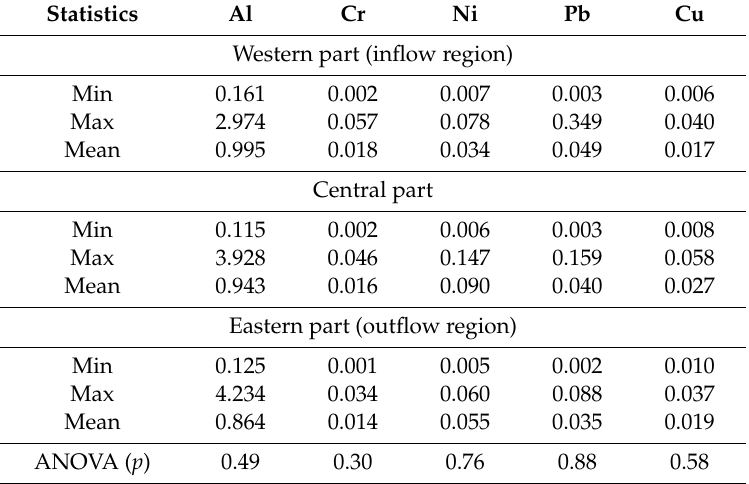
Table 3. Concentrations of major heavy metals in water (mg · L − 1 ) in 2014–2015 in the western (inflow), central, and eastern (outflow) parts of Lake Łebsko with ANOVA results.